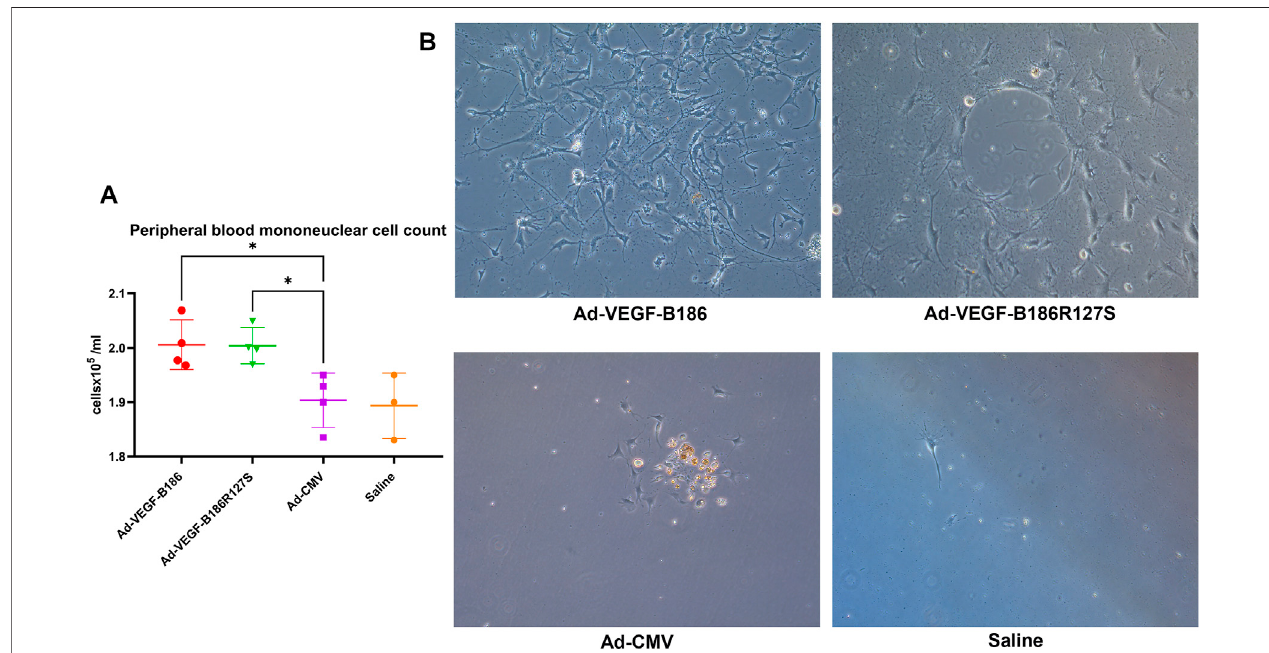
FIGURE7| Endothelialprogenitor cellgrowthfromcollectedperipheralbloodmononuclearcells. (A) Comparison ofthenumber ofcirculating PBMCs6 daysafter intramyocardial gene transfer. Each dot indicates one mouse; n = 4 in Ad-VEGF-B186, n = 4 in Ad-VEGF-B186R127S, n = 4 in Ad-CMV, and n = 3 in saline groups. Horizontal bars indicate mean ± SD and p values vs. each group by one-way ANOVA, followed by Dunnett ’ s multiple comparison test. ( B) Representative images of cultured EPCs on culture day 14 (10× zoom).